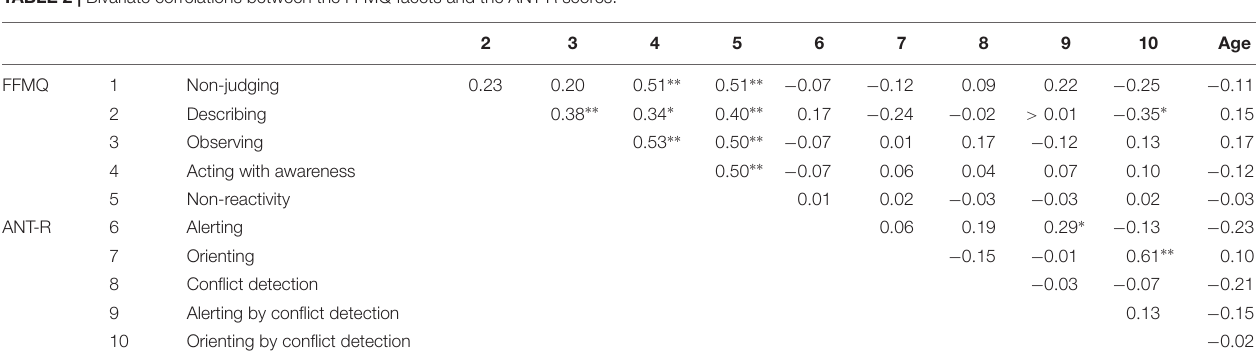
TABLE 2 | Bivariate correlations between the FFMQ facets and the ANT-R